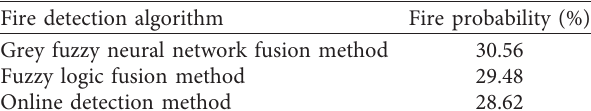
Figure 5: The relationship curve between the number of judgment matrices k and the false alarm rate of fire detection. Table 4: The real value of fire probability corresponding to the three detection algorithms.